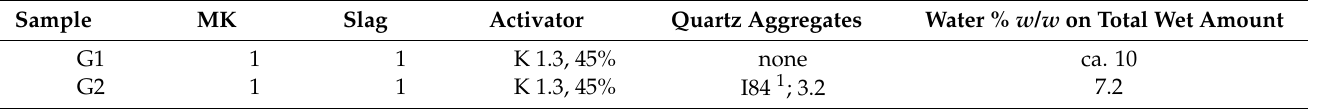
Table 1. Labeling and composition of the G1 and G2